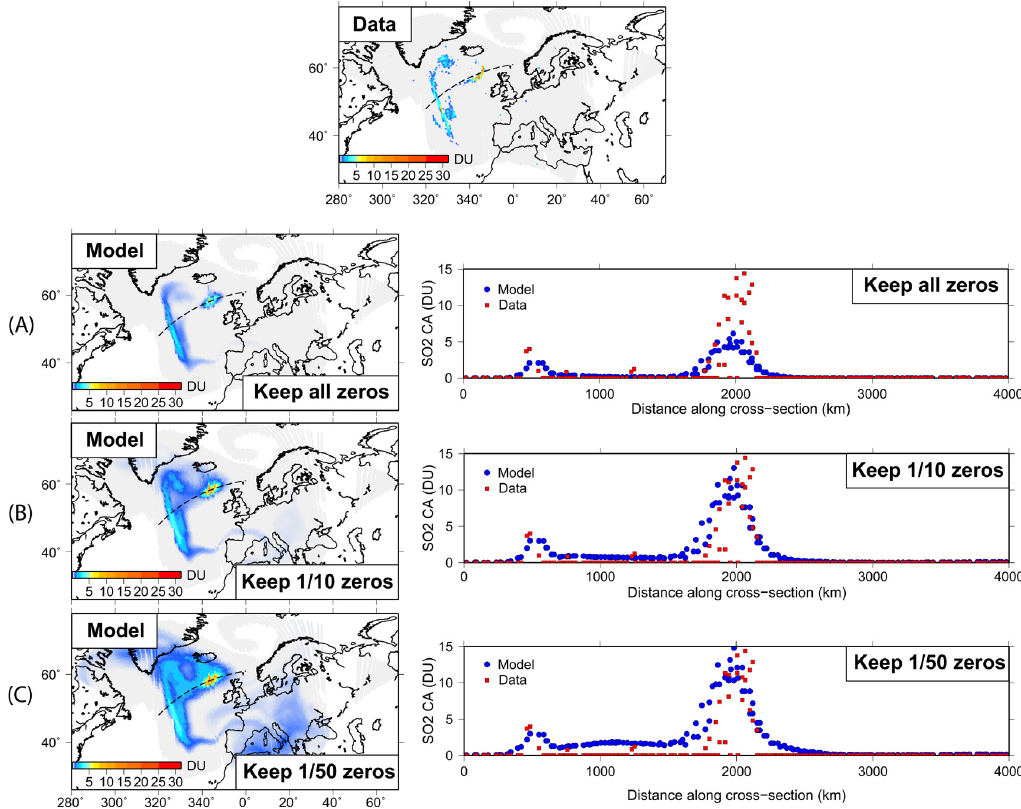
Fig. 2. Comparison of observed (top) and modelled (bottom left) plume SO 2 column amount (DU) maps for various of random data decima- tion before the inversion procedure: (bottom A ) all null observations yielding a zero SO 2 column amount are kept in the inversion scheme, (bottom B ) 1 out of 10 null observations are kept, and (bottom C ) 1 out of 50 null observations are kept. (Bottom right) Values of observed (red) and modelled (blue) SO 2 column amounts (DU) along the plume cross-section (dashed line on maps) retrieved according to data sampling. Maps are associated with IASI observations acquired on 9 May 2010 over a 12h window centred at